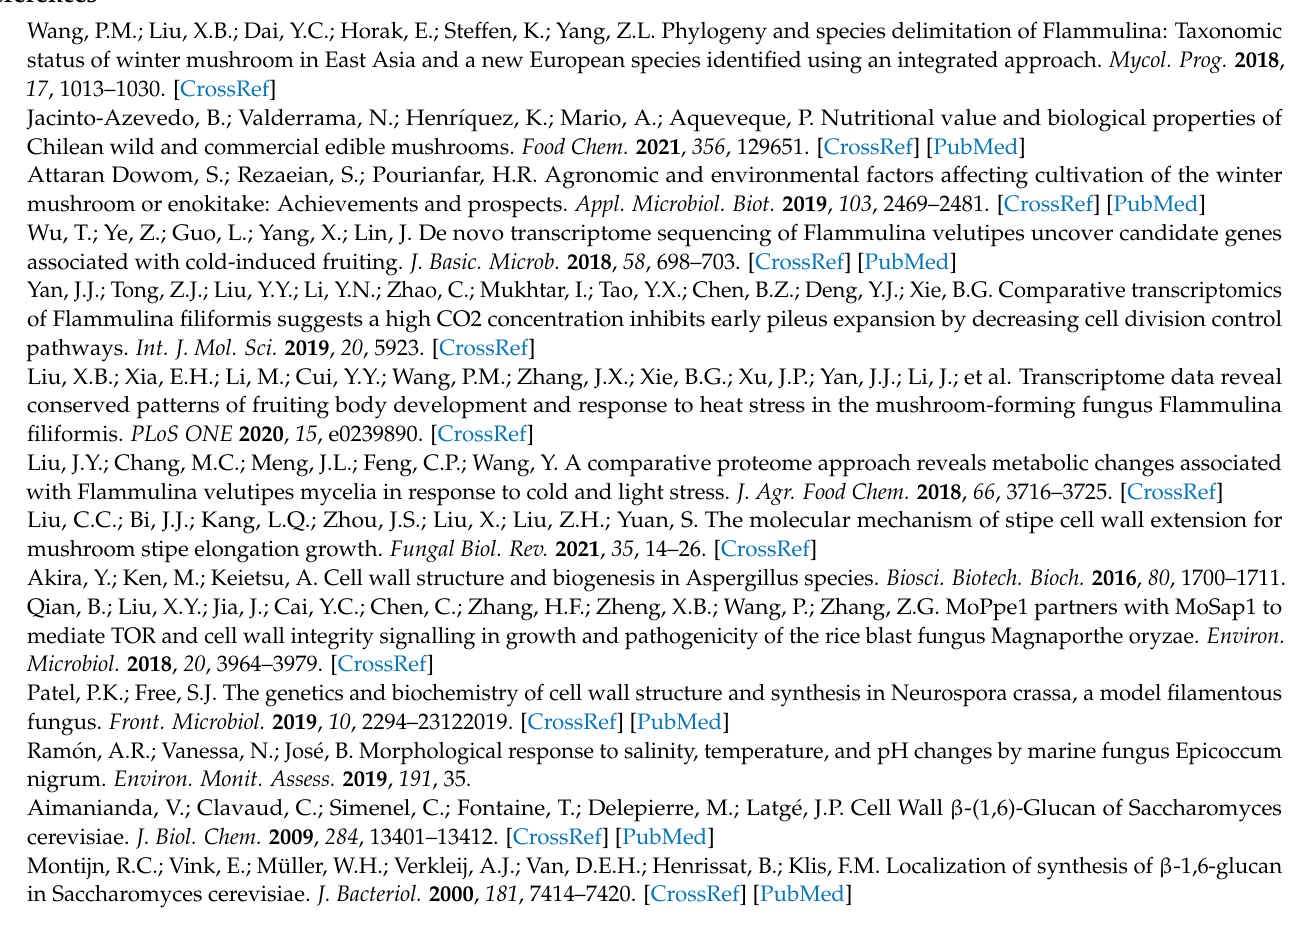
F. filiformis FfGS6 overexpression transformants; Figure S2: FfGS6 gene expression at different recovery time points (0, 2, 4, 6, 12, and 24 h) after Fv01 mycelial uninjured induction. ( t -test, n = 3); Table